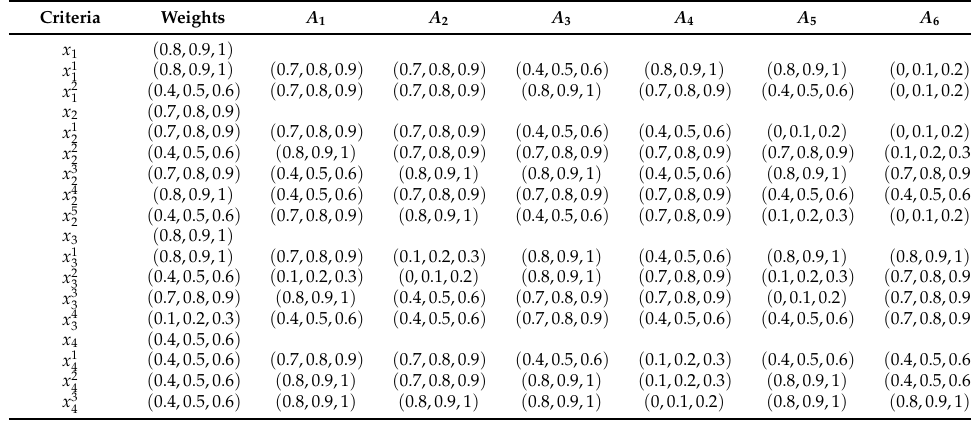
Table 3. Triangular fuzzy number evaluation with respect to cabinet frame.